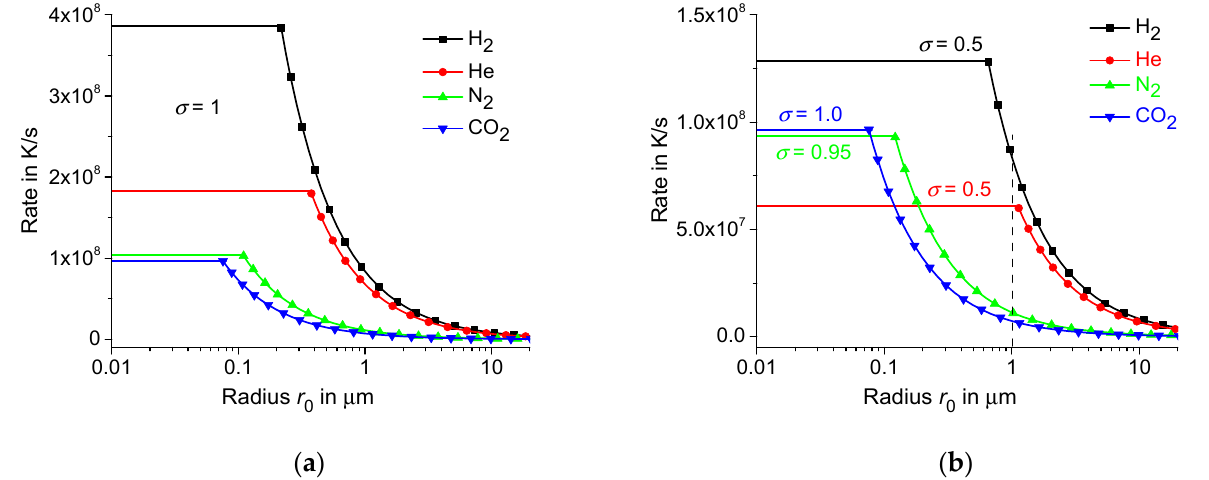
Figure 2. Possible cooling rate R vs. the radius r 0 of the hot zone for blackened ( a ) and bright ( b ) membrane surfaces for different gases.